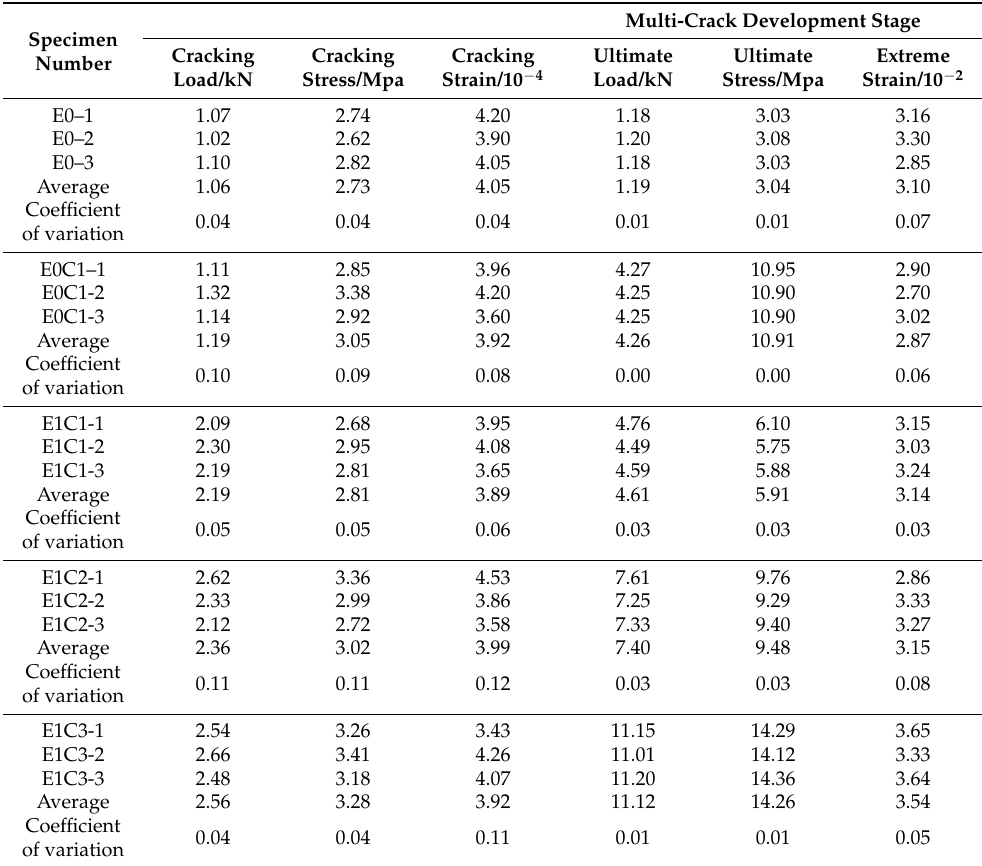
Table 5. Tensile test results of FRP grid-reinforced ECC